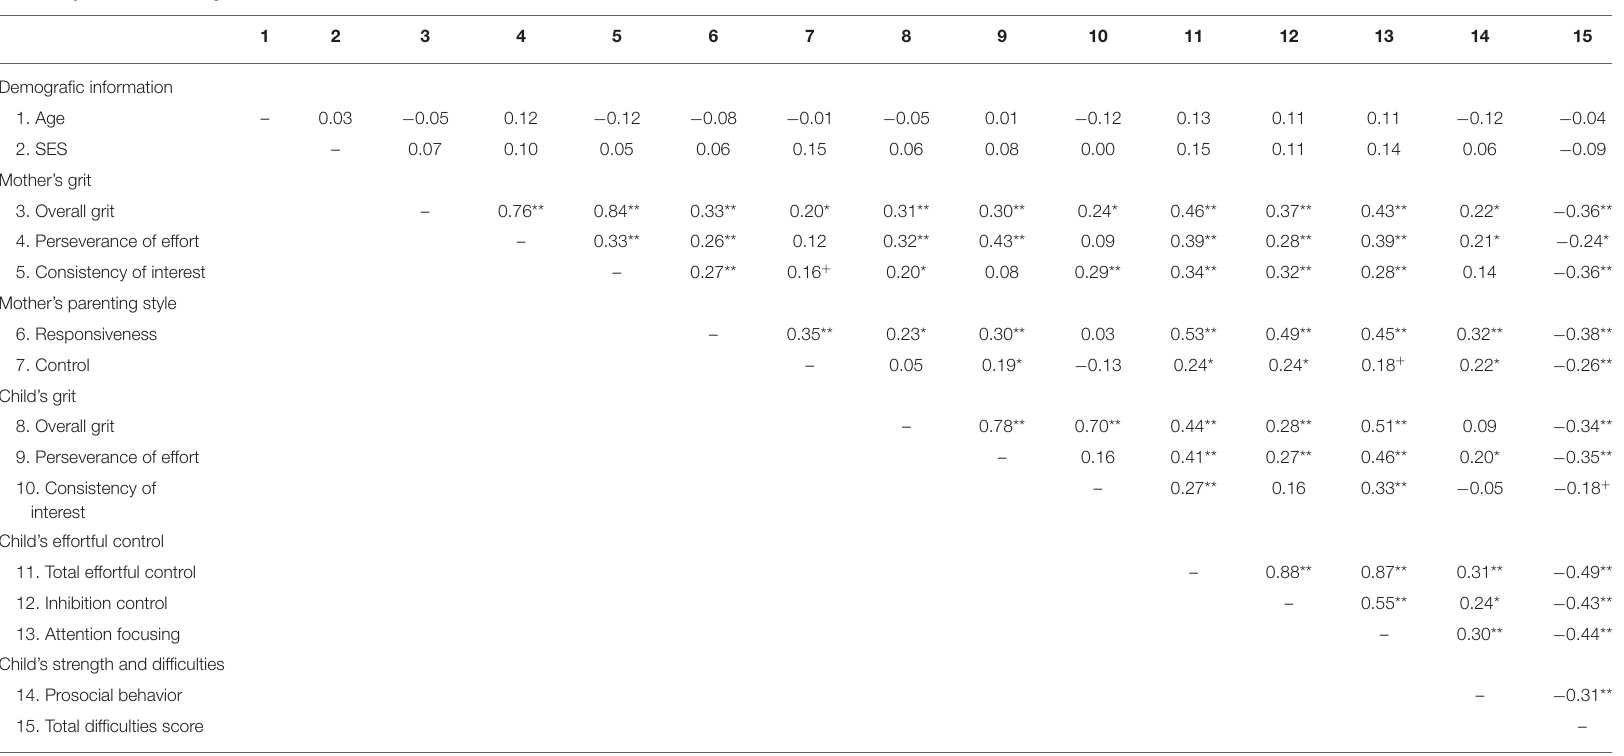
TABLE 1 | Correlation among